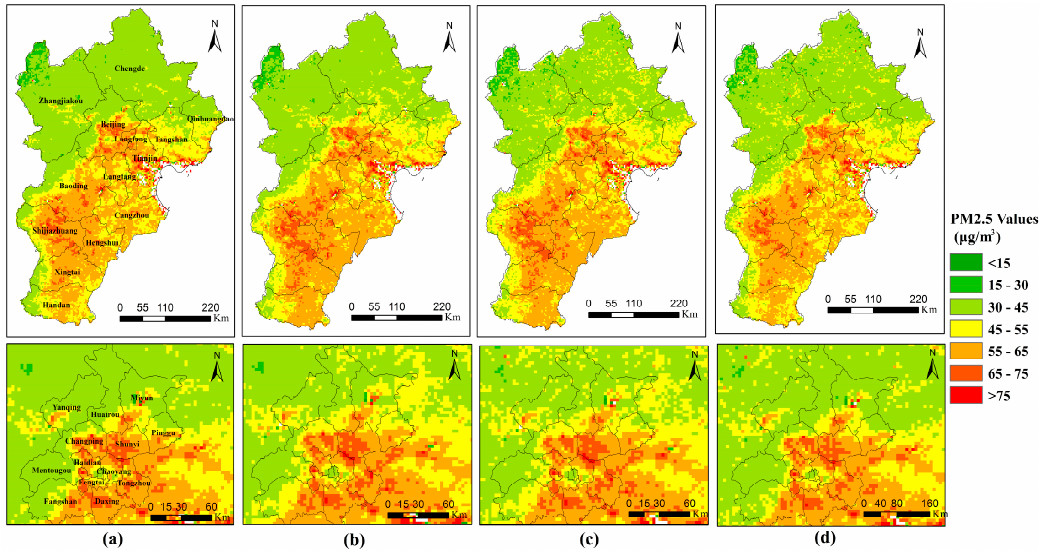
Figure 4. Annual mean PM 2.5 concentration predictions by the different models: ( a ) Meteor_LME, ( b ) NDVI_LME, ( c ) NTL_LME, and ( d ) VANUI_LME.